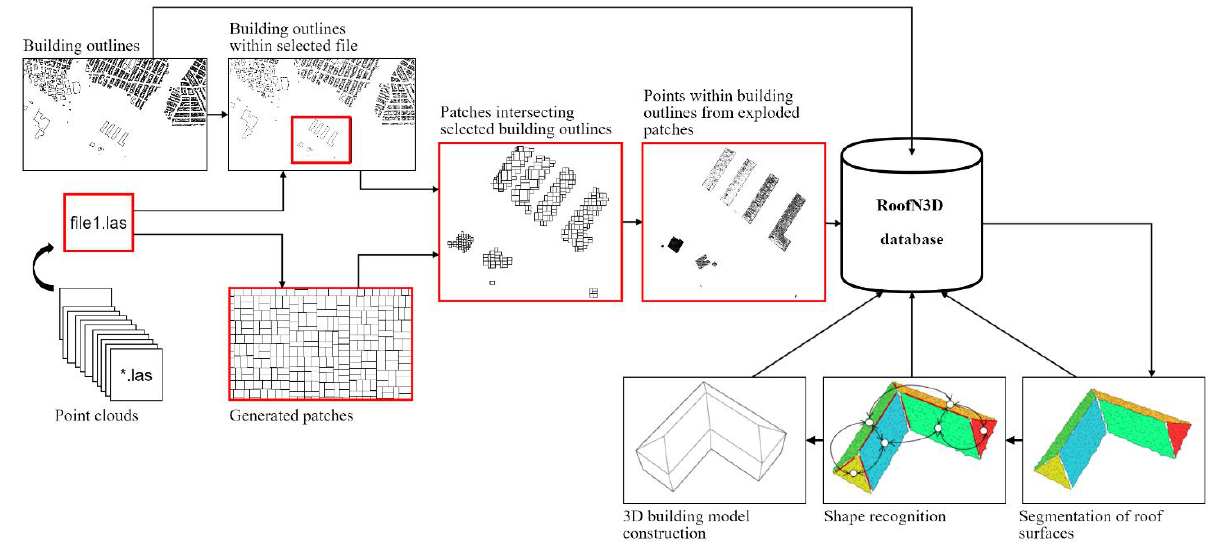
Figure 4. Framework for the automatic preparation of data that is needed to train neural networks in deep learning